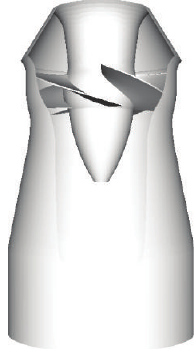
Figure 1: The computational domain.